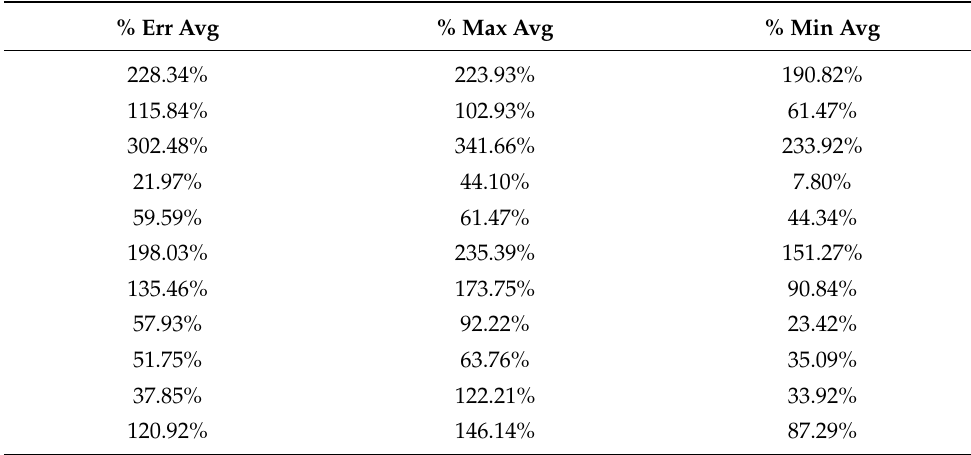
Table A167. Set 3, trials 1–10 data (all 0.5 PR values).